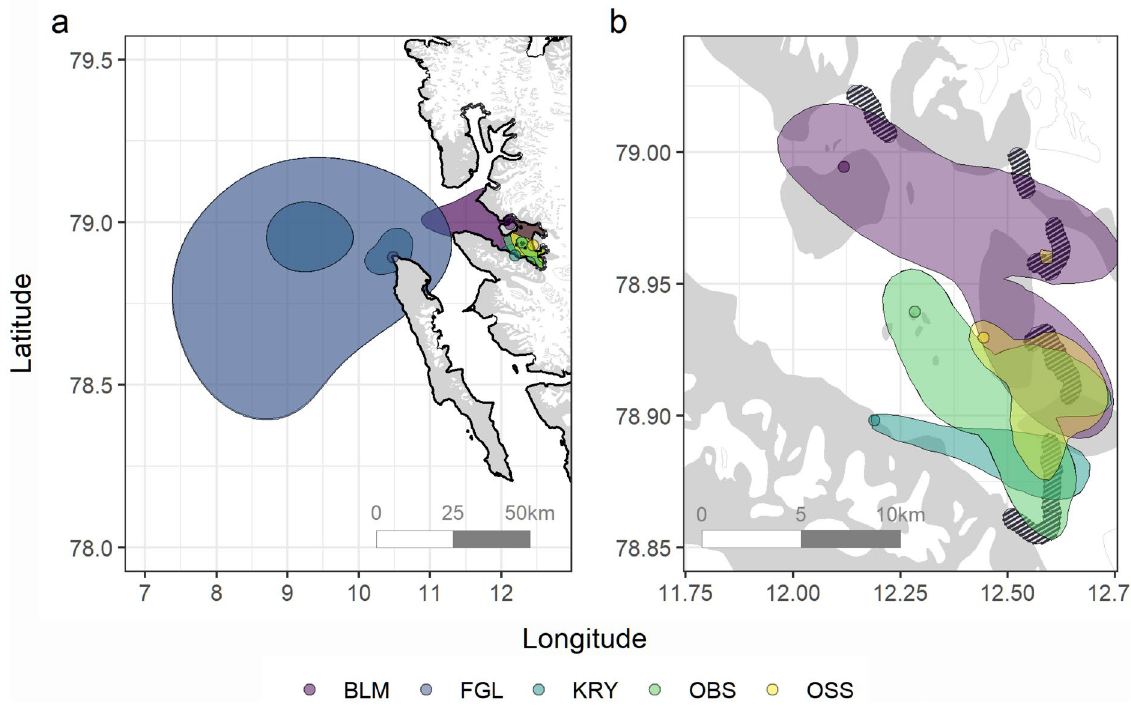
Figure 2. ( a ) Study area and the mean utilization distribution (UD) estimated for each kittiwake breeding colony (95% and 50% isopleths based on the individuals’ UD weighted by the number of trips sampled per individual; BLM (purple) = Blomstrand, FGL (dark blue) = Fuglehuken, KRY (cyan) = Krykkjefjellet, OBS (green) = Observasjonsholmen, OSS (yellow) = Ossian Sarsfjellet) and ( b ) core-ranges (50% isopleths) for the four colonies (circles) located within Kongsfjorden. Glacier fronts (crosshatched) are also shown. All birds were tracked during the chick-rearing period in 2017. Maps were generated using R (version 4.0.2 42 ; URL: https:// www.R- proje ct. org/).